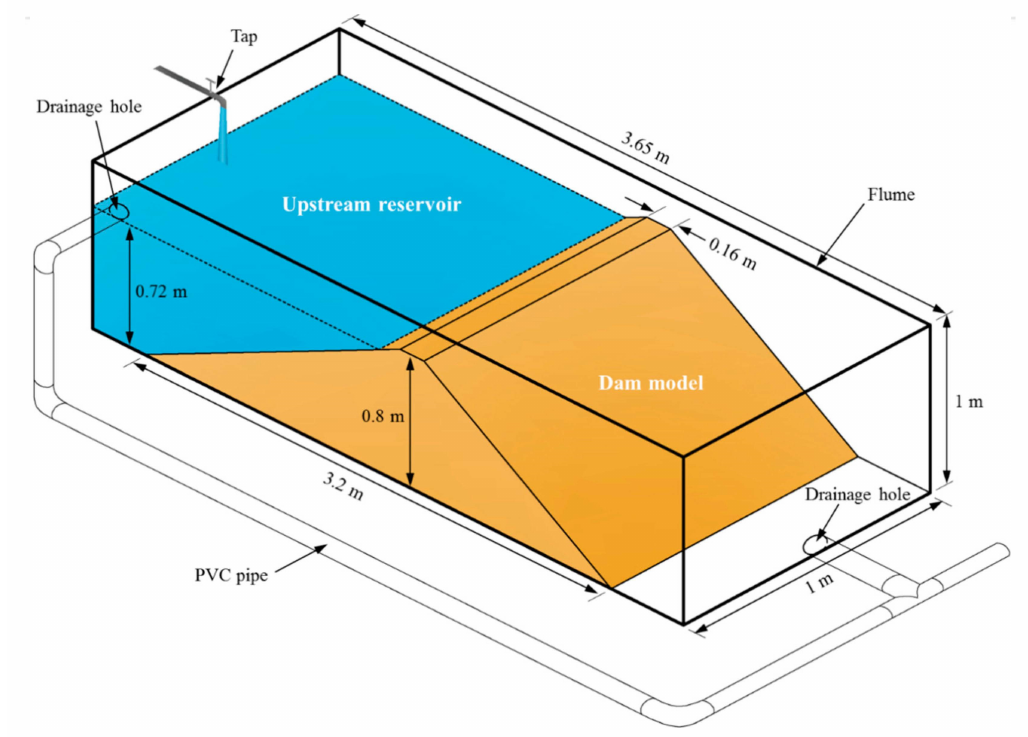
Figure 1. Schematic of a flume and a dam model constructed in the